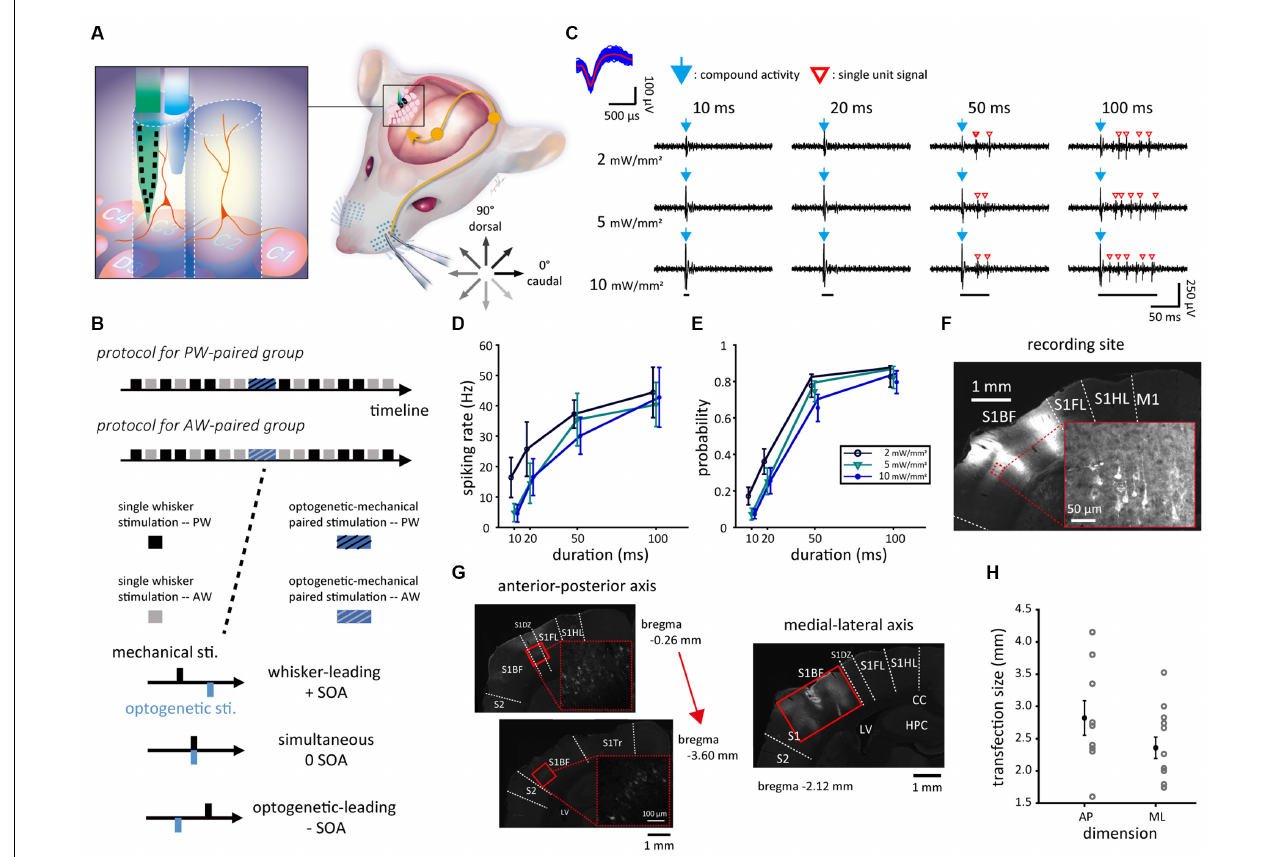
FIGURE 1 | Experimental setup and neuronal responses to mechanical, optogenetic, and paired stimulations. (A) The experimental setup of single-unit recording in S1BF via the probe-fiber bundle when presenting mechanical (whisker), optogenetic, or paired stimulations. During mechanical stimulation, the whisker was deflected in one of the eight directions. The tactile afferent signals were relayed to the ipsilateral brainstem and ascended to the contralateral thalamus then the S1. The left panel shows the experimental setup in which CaMKII-mCherry-expressing neurons (red) were optogenetically stimulated by laser light delivered into S1BF via an optical fiber (blue) that bundled with the electrode probe (green). (B) The experiment consists of the prepaired recording, paired stimulation, and postpaired recording. The SOAs were − 40 to 40 ms in 10-ms steps. (C) In a factorial design with four stimulation durations by three stimulation intensities, the duration was 10, 20, 50, or 100 ms and the intensity was 2, 5, or 10 mW/mm 2 . The responses of sample single unit (top left) isolated from the recorded spike trains during optogenetic stimulations showed compound activities (blue arrows) as a prompt response to the onset of optogenetic stimulation (bottom) and a series of isolated single-unit responses (red empty arrowheads). (D) Data averaged from 17 single units obtained from the four animals showed that the spiking rate monotonously increased with the stimulus duration and was relatively weakly affected by the stimulus intensity. (E) A similar trend was also found in firing probability. (F) The fluorescence image showed that rAAV-transfected neurons, which expressed mCherry (in the magnification view with red outlines), located in S1BF. The disconnected area of mCherry fluorescence in S1BF was the recording site, which showed the tissue change induced by the insertion of the probe-fiber bundle. (G) Neurons transfected with rAAV expressed mCherry (highlighted in high magnification views marked in dashed red squares), locating mainly in S1BF as shown in the coronal brain slices in an anterior-to-posterior order. Solid red rectangles represent the transfection area, in which mCherry-expressing cell bodies can be observed. (H) The size of the transfection area measured in the anterior-posterior (AP) and medial-lateral (ML) dimensions. Error bars represent the mean ± s.e.m. and dots represent data for animals. S1, primary somatosensory cortex; S1BF, S1 barrel field; S1DZ, S1 dysgranular zone; S1FL, S1 forelimb region; S1HL, S1 hindlimb region; S1Tr, S1 trunk region; S2, secondary somatosensory cortex; CC, corpus callosum; LV, lateral ventricle; HPC, hippocampus; D3V, dorsal third ventricle; SOA, stimulus onset